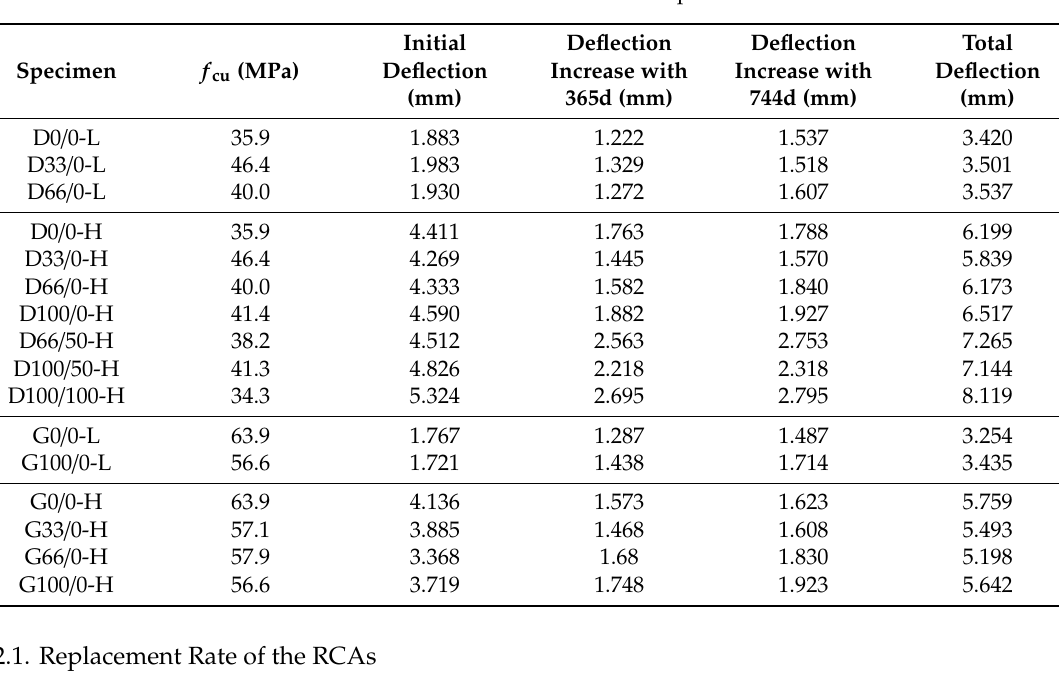
Table 5. Tested deflection values of the specimens.